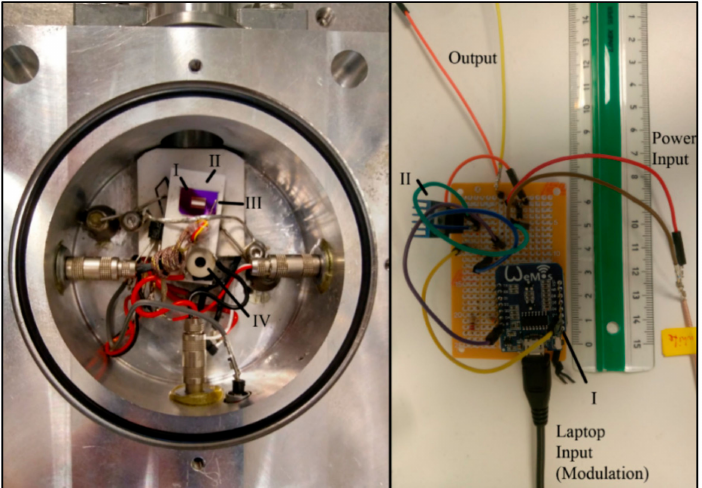
Figure 2. Left: Measurement chamber, I . Microchip, II : Peltier element, III : Thermocouple, IV : Piezo actuator, right: Controller used to create the temperature modulation, I : Microcontroller Wemos D1 mini, II :